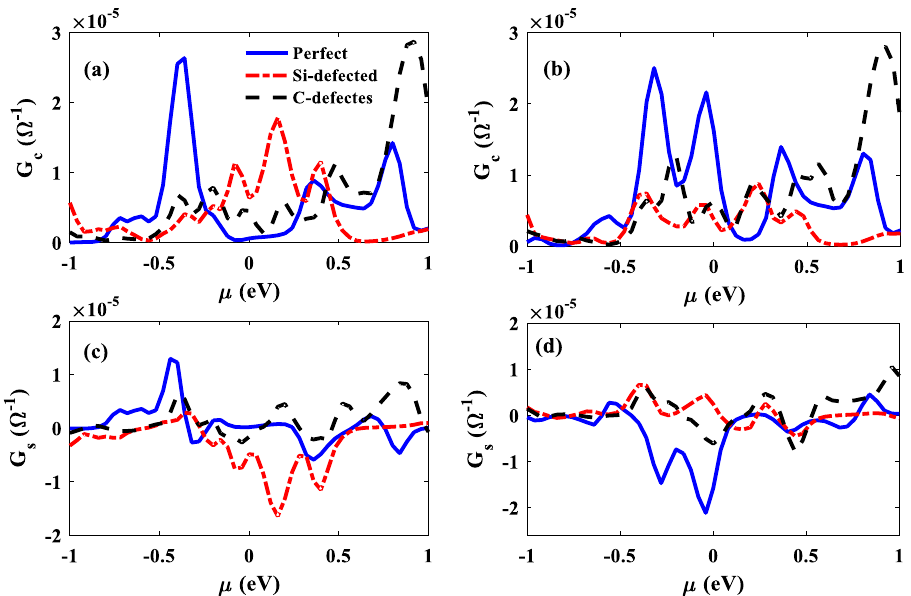
Figure 5. The electrical conductance, G e , and the spin conductance, G s , of the perfect (solid lines), Si-defected (dot-dashed lines), and C-defected (dashed lines) of junctions as a function of chemical potential for P ( a and c ) and AP ( b and d ) electrodes configurations